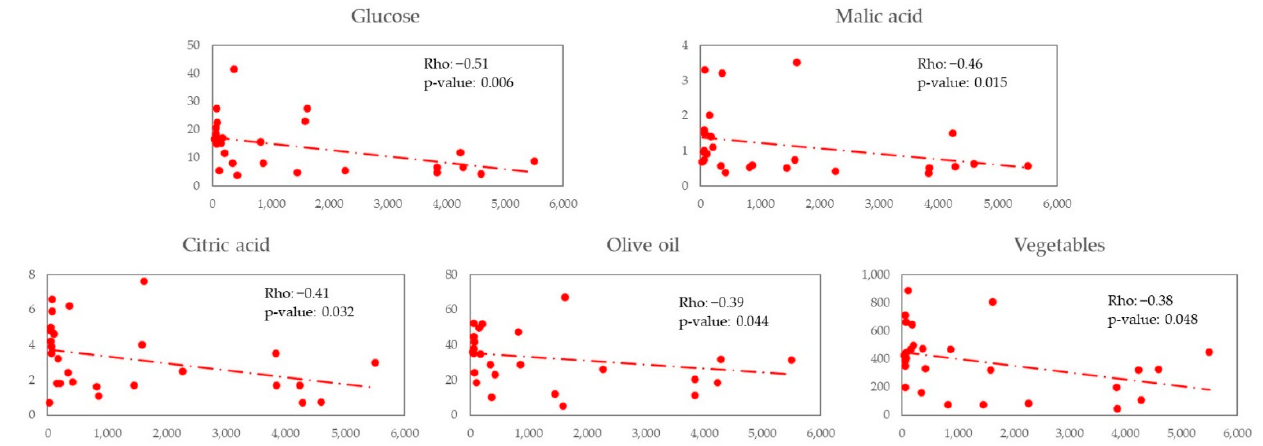
Figure 5. Scatter plot X— Bacteroides , Y—Nutrients/Food.